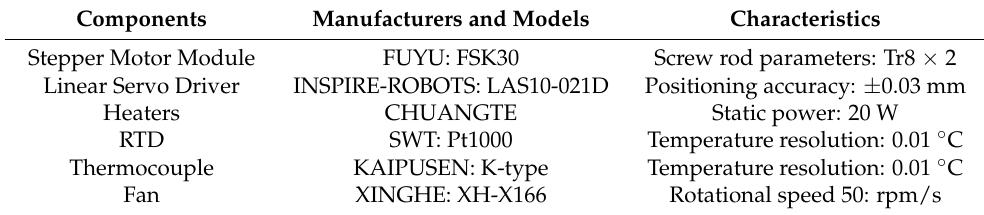
Table A3. Component performance parameters.